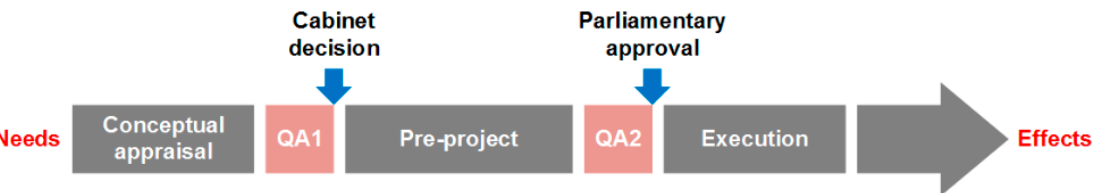
Figure 3. The State Project Model.